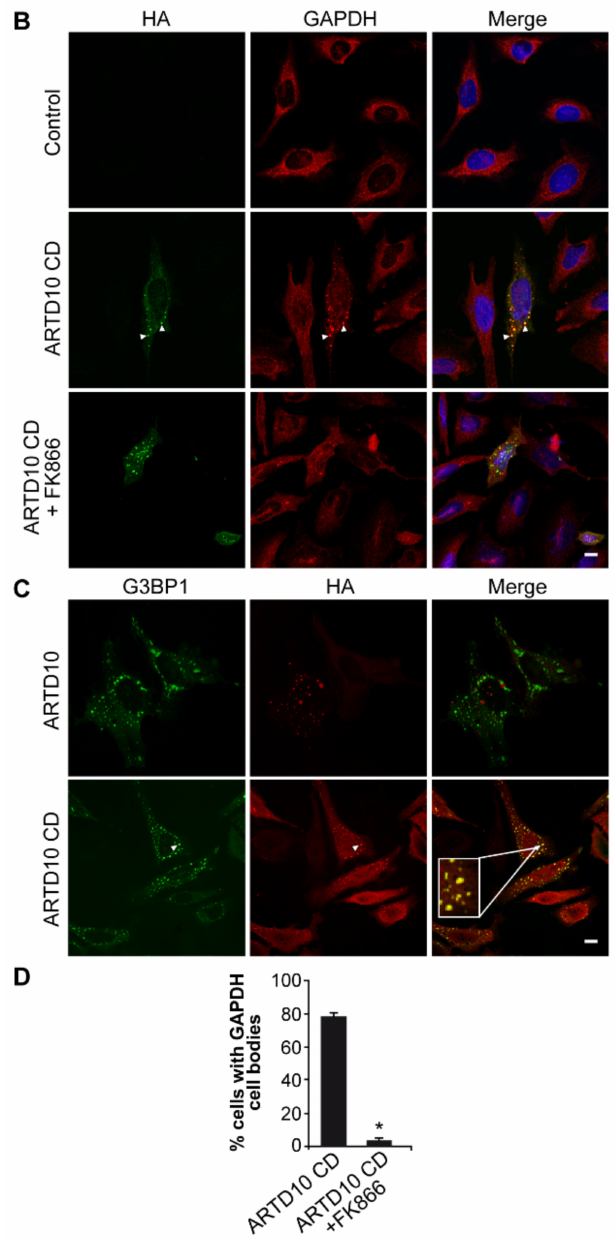
Figure 6. ARTD10/PARP10-CD localises in stress granules. Representative immunofluorescence microscopy of HeLa cells. ( A , B ) Cells were mock transfected (Control), or were transiently transfected with HA-ARTD10-CD without ( A ) and with ( B ) treatment with FK866 (as indicated). ( A ) The cells were incubated with m Af1521 and stained with anti-GST (GST; green) and anti-HA (HA; red) antibodies (as indicated); ( B ) The cells were stained with anti-HA (HA; green) and anti-GAPDH (GAPDH; red) antibodies; ( C ) Cells were transiently transfected with GFP-G3BP1 and with HA-ARTD10 or HA-ARTD10 CD (as indicated). The cells were then stained with anti-HA (HA; red) antibody. Scale bars, 10 µ m. Data are representative of three independent experiments. The inset shows the localization of ARTD10 CD with GFP-G3BP1; ( D ) Quantification of % ARTD10-CD cytoplasmic cell bodies positive for GAPDH is shown, with the data expressed as means ± SD of three independent experiments. *, p <